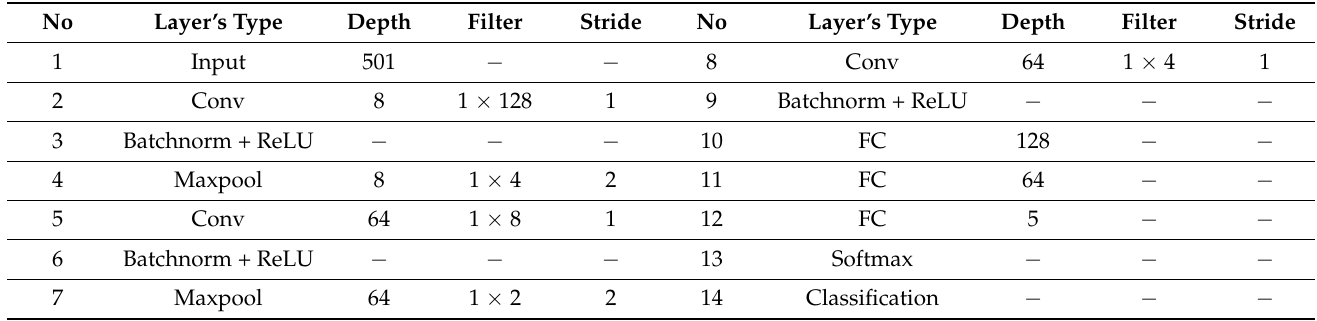
Table 1. The specification of the layers of the 1D CNN model.